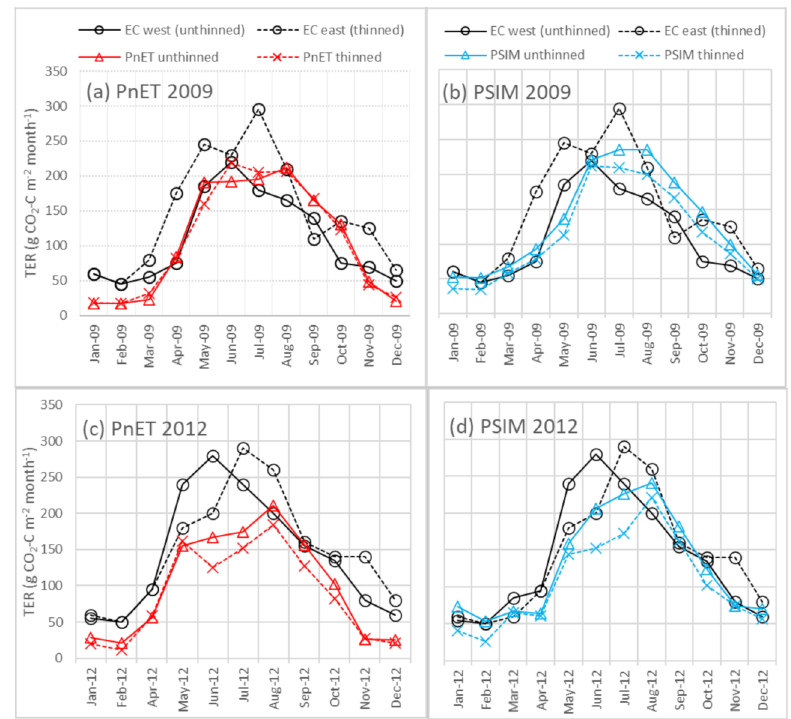
Figure 10. Monthly TER at the Straits Inclosure for 2009 ( a , b ) and 2012 ( c , d ). Measured EC TER data are separated into data originating from the eastern (thinned) sector and western (unthinned) sector [45]. Equivalent simulated TER data are shown for PnET ( a , c ) and PSIM ( b , d ) with 0% and 30% thinning after separating results depending on the daily wind